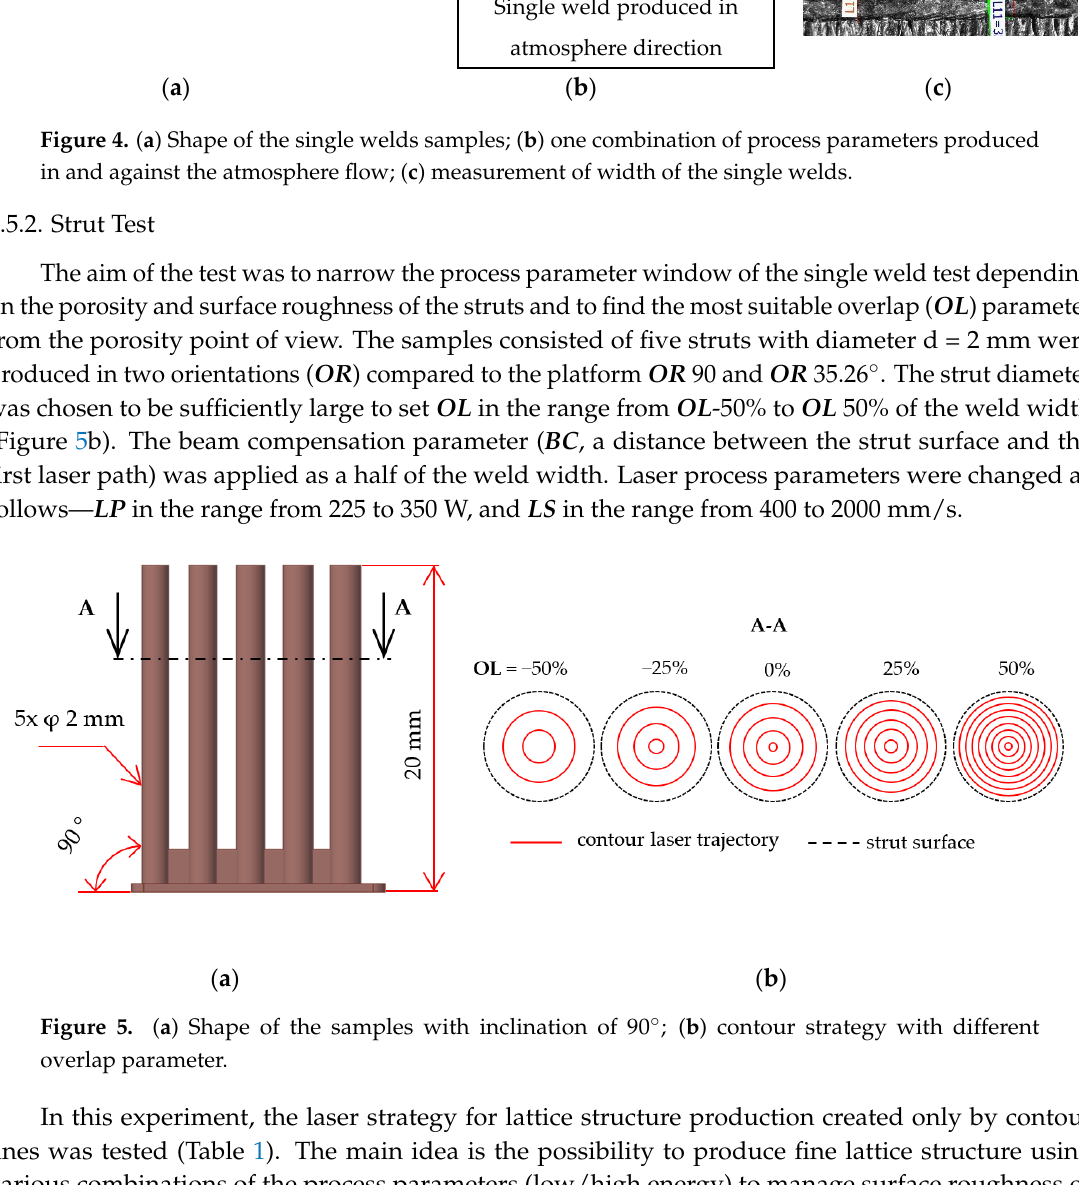
Table 1. Laser strategies of the strut with inclination of 35.26° (orientation in body centered cubic (BBC) lattice structure).